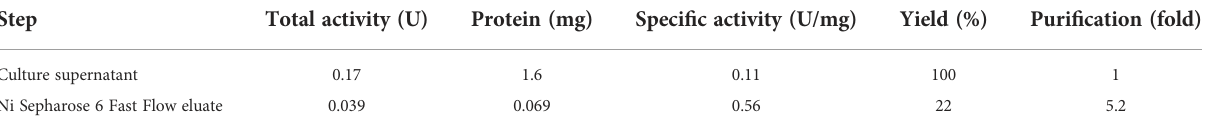
TABLE 2 Puri fi cation of rAoAgtA from the culture supernatant of the rAoAgtA-expressing P. pastoris strain. Step Total activity (U) Protein (mg)